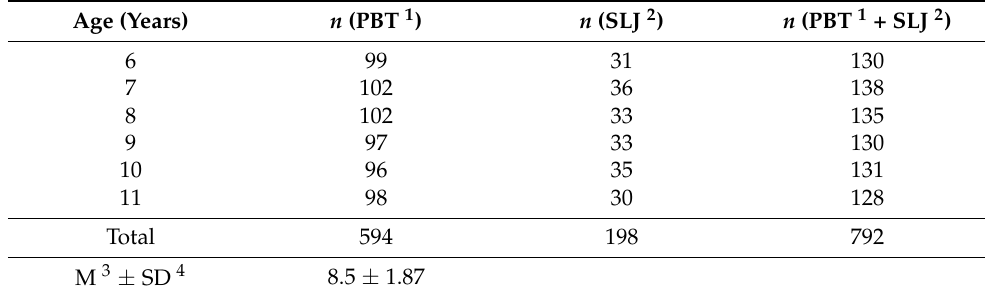
Table 1. Number of participants per age and experiment. Age (Years) n (PBT 1